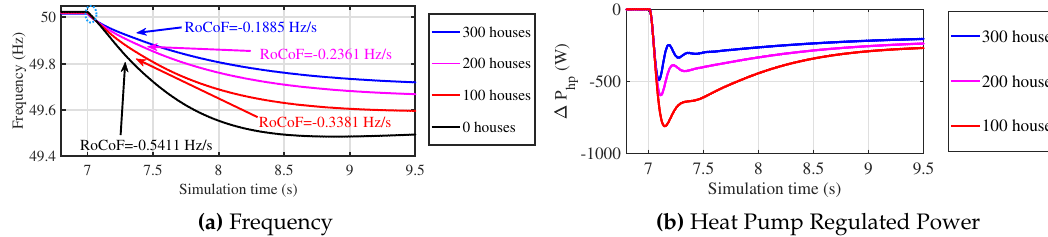
Figure 13. Response of the distribution system for different virtual inertia controller